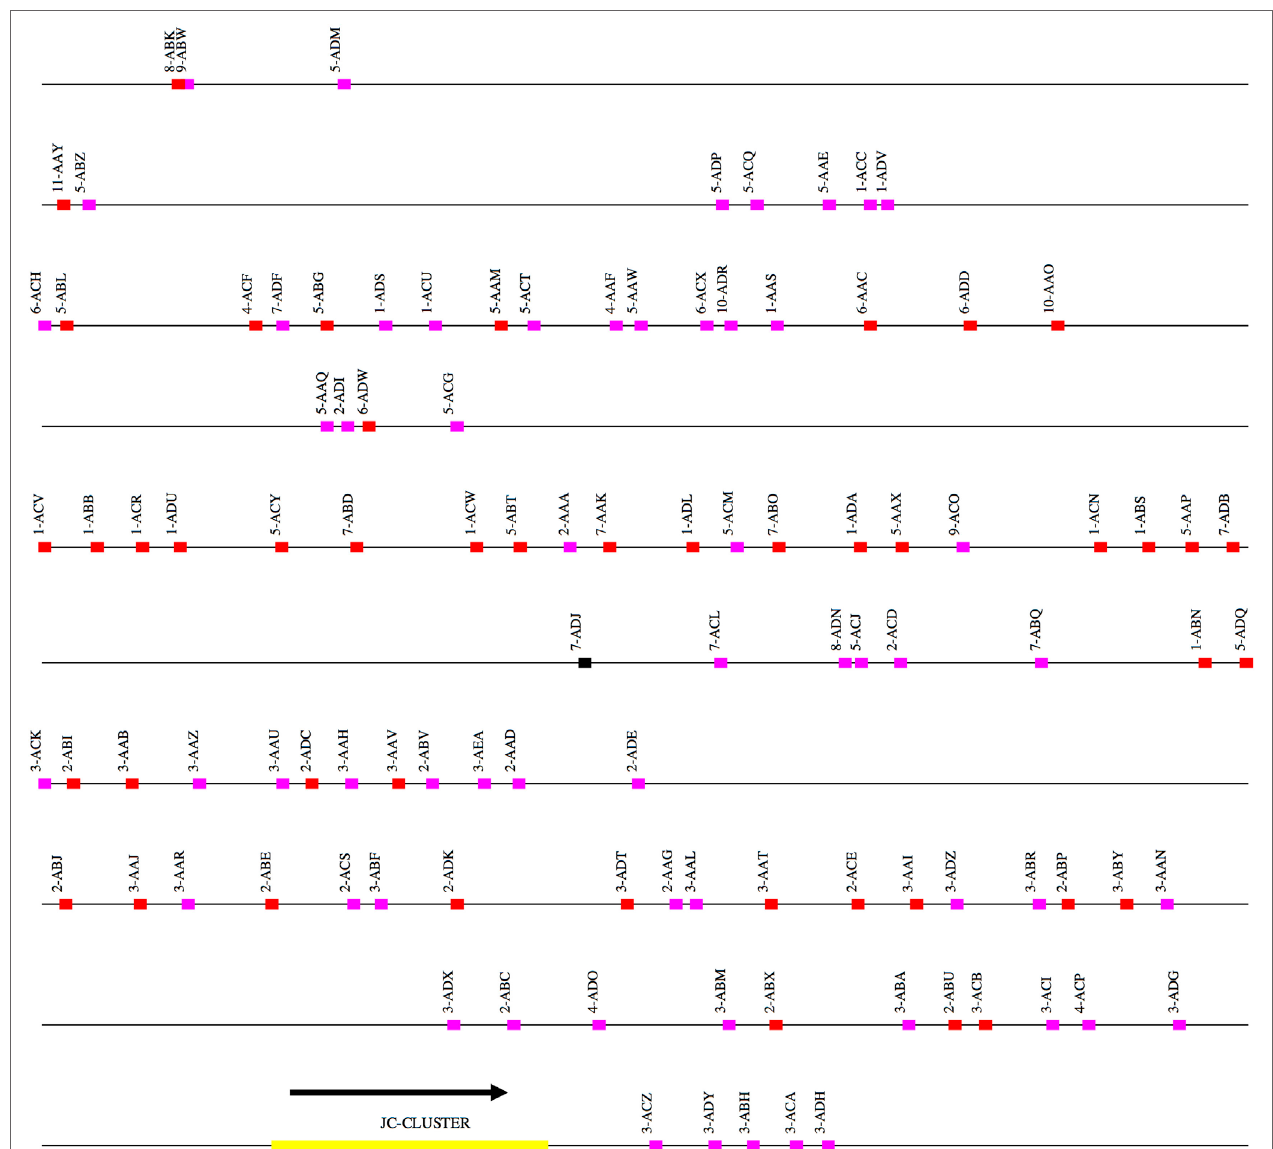
FigUre 3 | Schematic representation of the rhesus macaque IGL locus. A schematic representation of the rhesus IGK locus (plus strand). The order of the scaffolds was determined by ordering the rhesus macaque IGK scaffolds against the African Green Monkey IGK locus. The functional, non-functional, and open reading frame genes are represented in red, magenta, and black blocks, respectively. The JC cluster is represented as a yellow